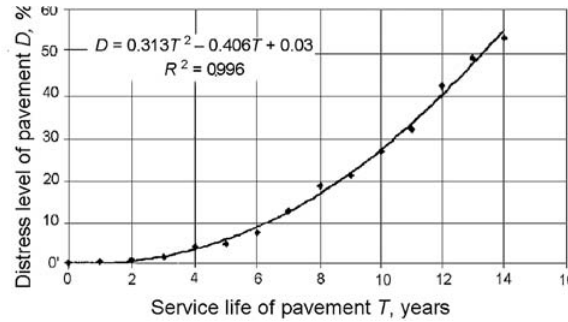
Fig. 2 . Interdependence of SL T of HMA pavement and its